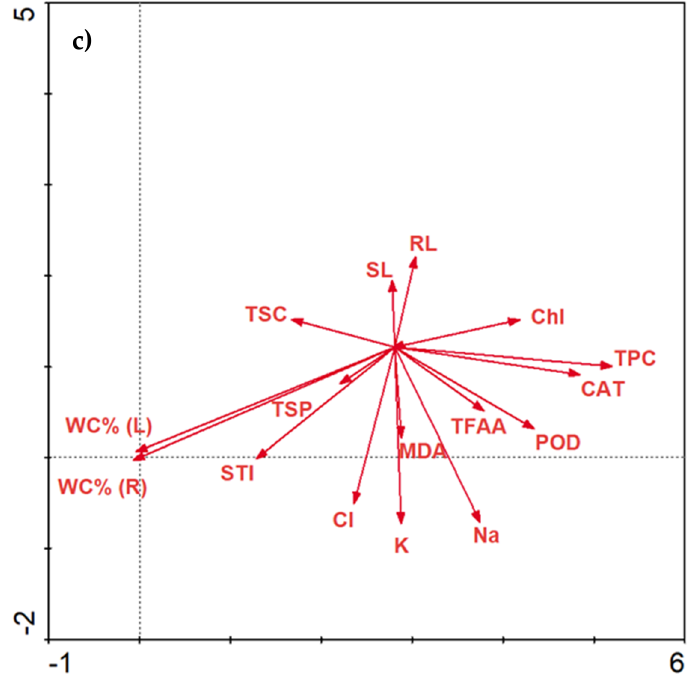
Figure 8. Redundancy analysis (RDA) of the data explained by environmental variables and treat- ments between salinity stress, molasses application and biochemical parameters. RDA 1—salinity stress at 0 mM NaCl level ( a ); RDA2—salinity stress at 100 mM NaCl level ( b ); RDA 3—salinity stress at 200 mM NaCl level ( c ).